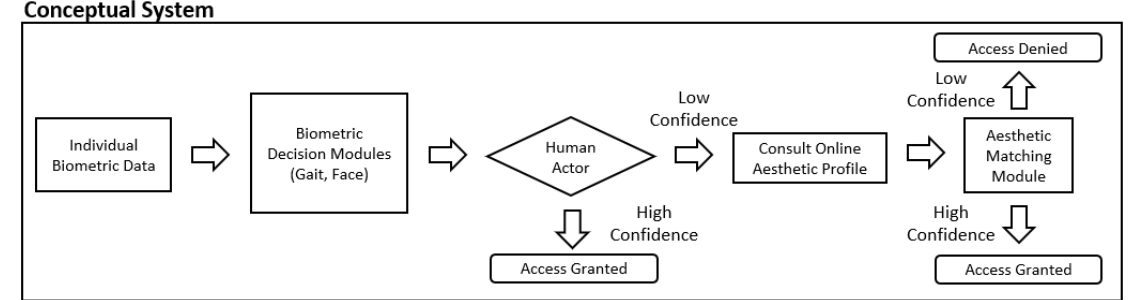
Figure 2. The conceptual flowchart of a human-assisted decision-making